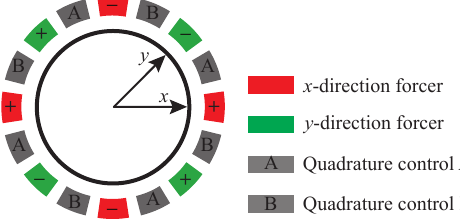
Figure 6. Electrode configuration for MRRs with 16 actuation